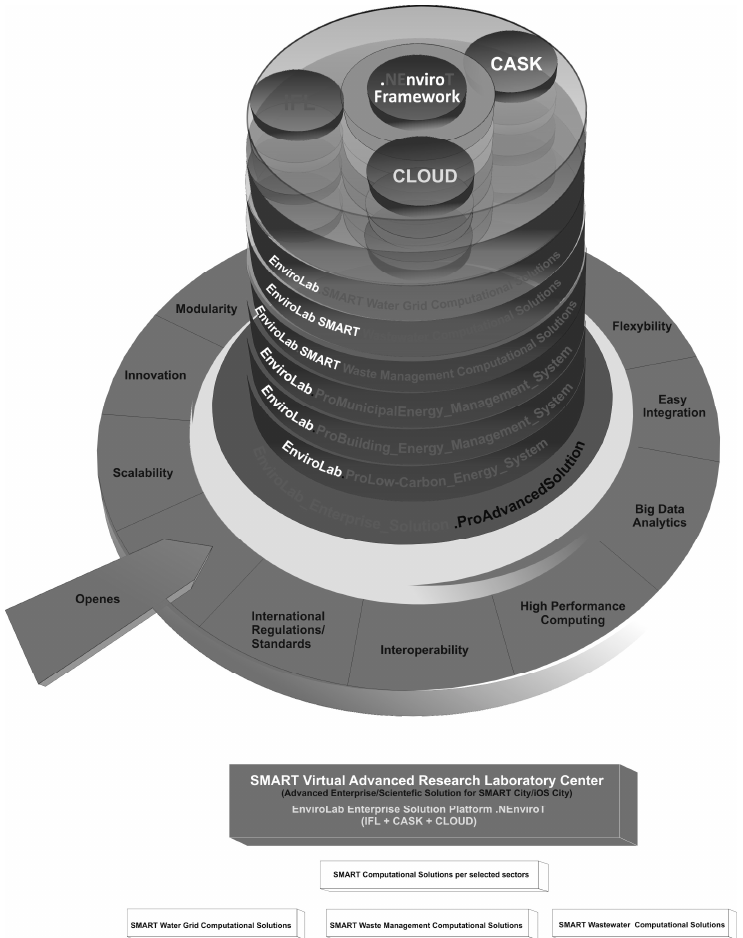
Figure 1. Logical structure of the virtualized research space model [own elaboration].